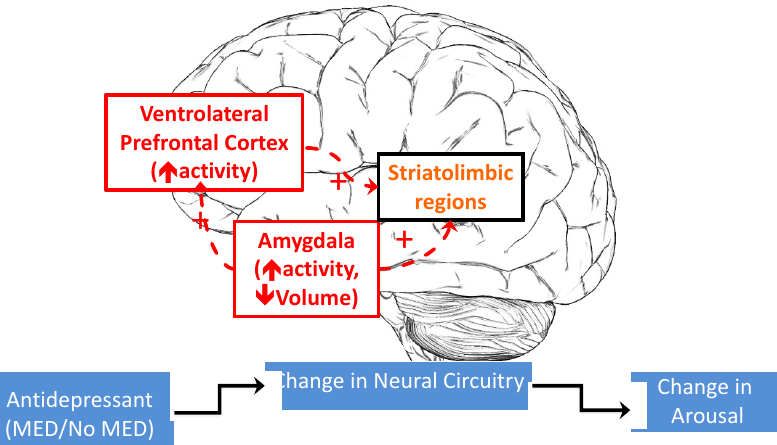
Figure 2. Conceptual framework for the formal evaluation of neural mechanisms of change as mediating medication effect on the development of hyperarousal. Legend: ↑ = increase; ↓ = decrease; + = hyperconnectivity